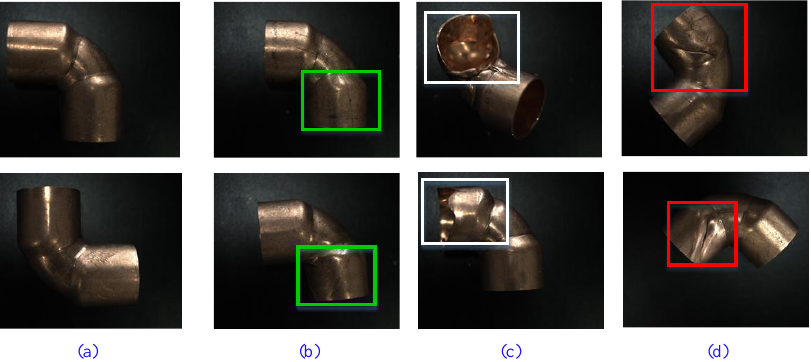
Figure 5. Some images of the copper elbow surface. ( a ) Defect-free. ( b ) Extrusion. ( c ) Crack. ( d ) Pitted-surface.